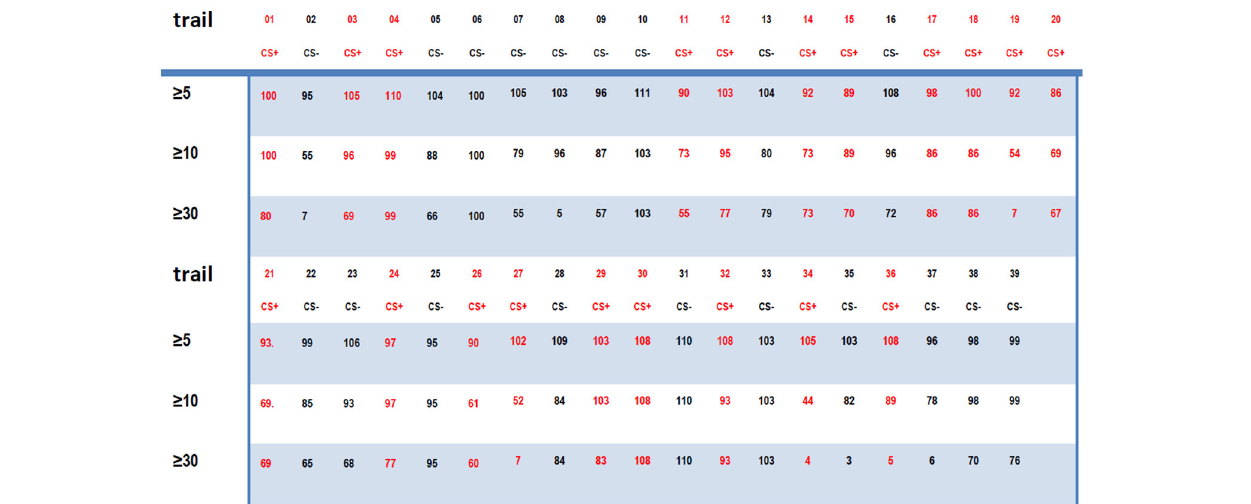
trails (A) and PLV for CS trails (B) + −